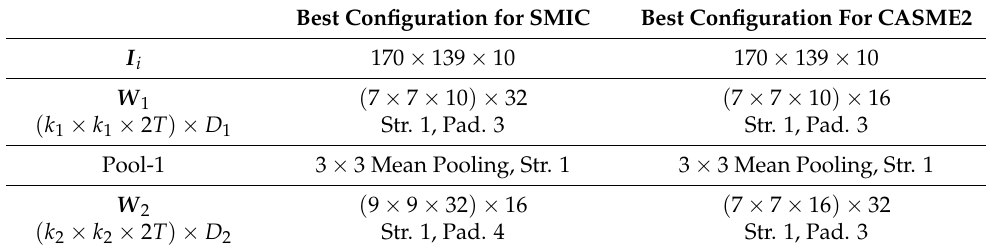
Table 5. Summary of the configuration of PCANet+ network.